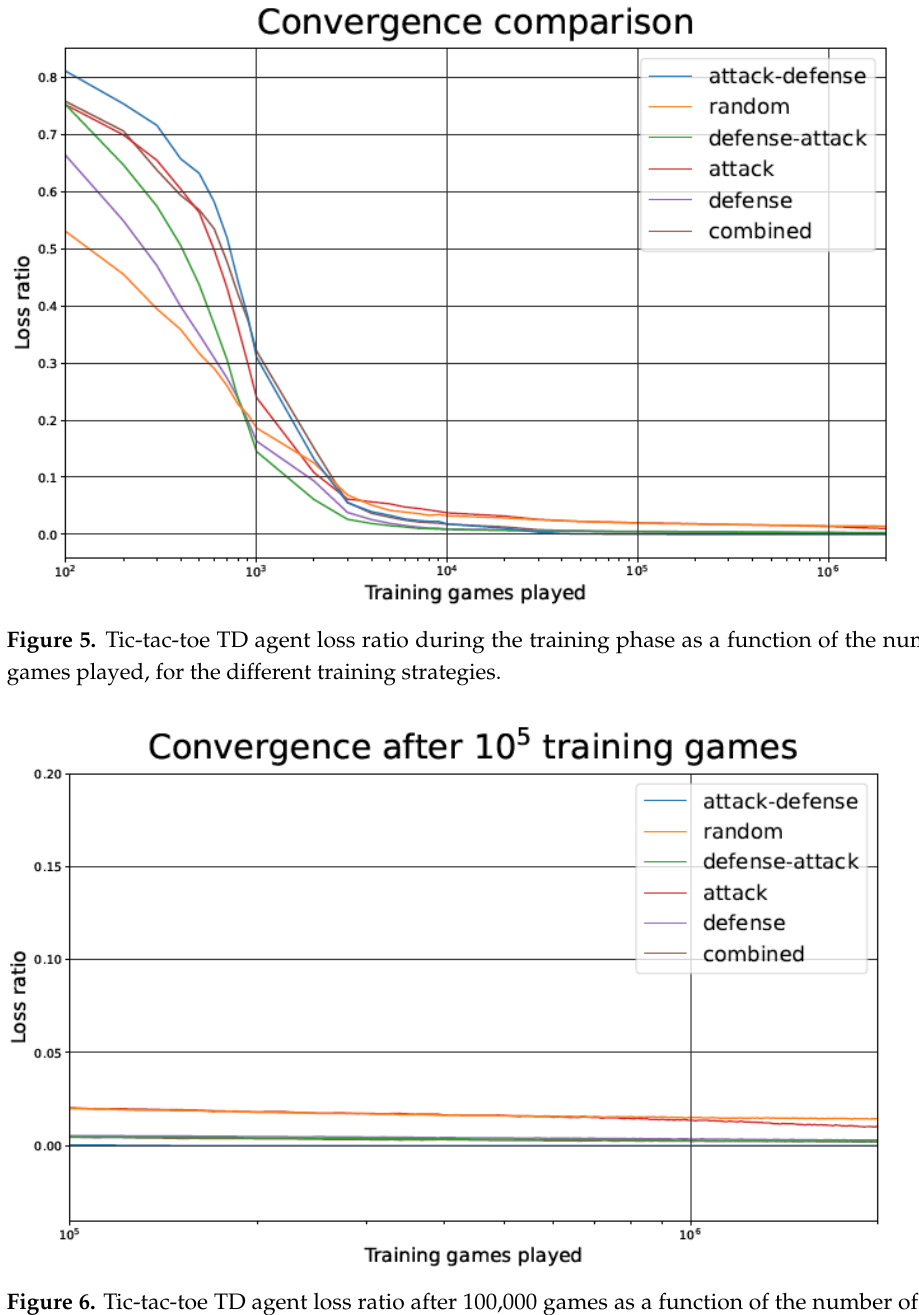
Figure 6. Tic-tac-toe TD agent loss ratio after 100,000 games as a function of the number of games played, for the different training strategies.